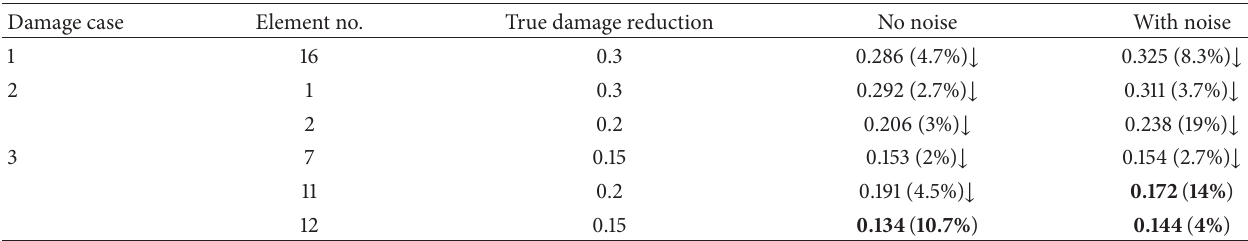
Table 4: The results obtained by the universal fast algorithm (Example 2).